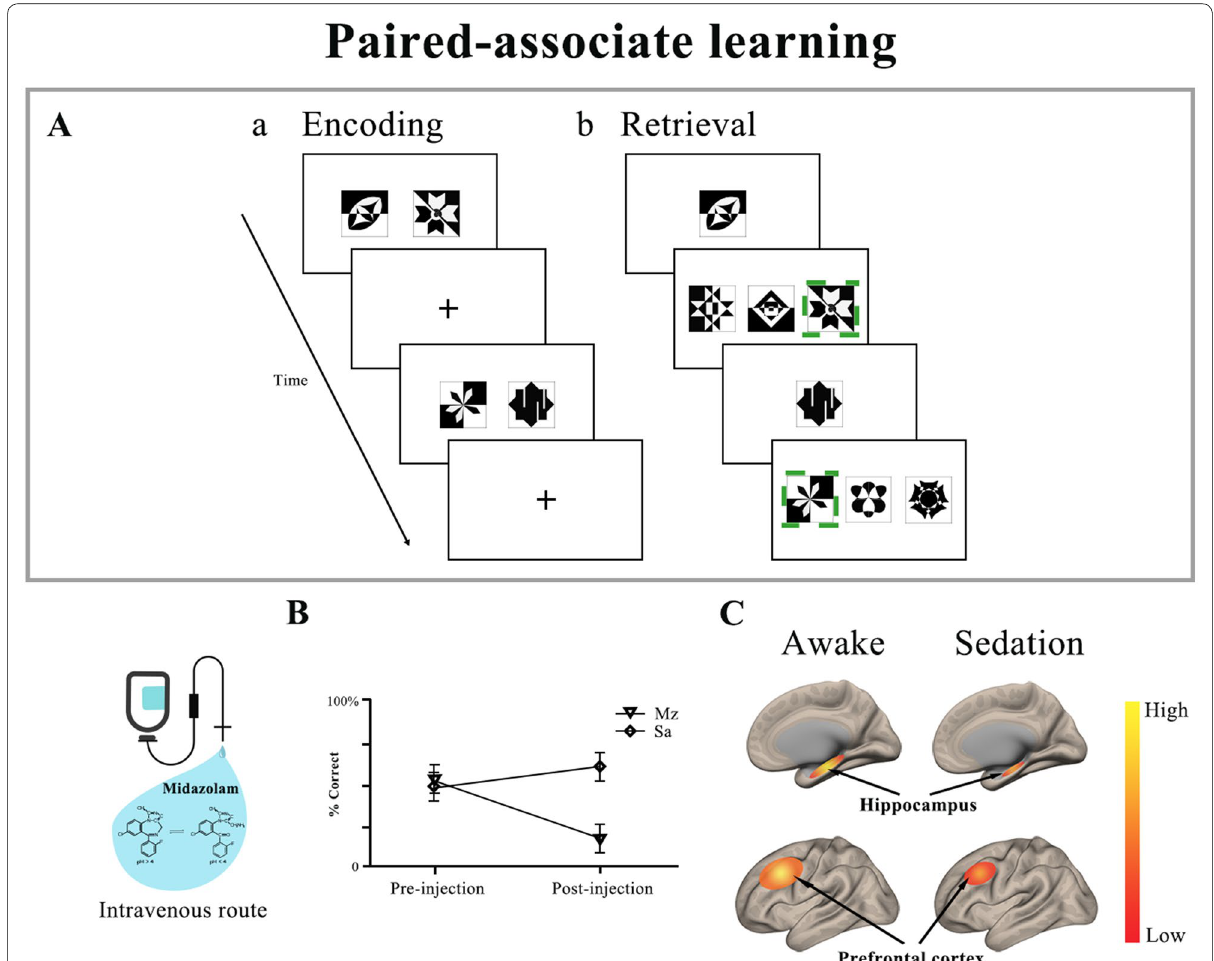
Fig. 1 The effect of midazolam on visual paired-associate learning. A A schematic of the two parts of the visual paired-associate learning task consisting of (a) an encoding task, and (b) a cued recall task. B The effect of midazolam on encoding and retrieval of new information after drug administration. Individuals with intravenous midazolam showed a marked decrease in encoding and retrieval trials than subjects with saline. The hippocampus and prefrontal cortex were involved in paired-associate learning and midazolam significantly decreased the activation of hippocampus and prefrontal cortex in trials requiring encoding and retrieval of new